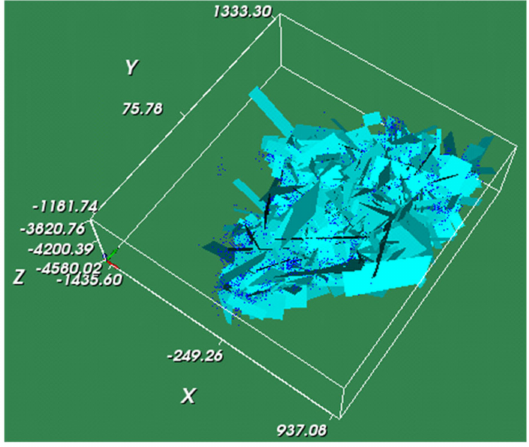
Figure 19. Habanero fracture model derived by MCMC optimization.